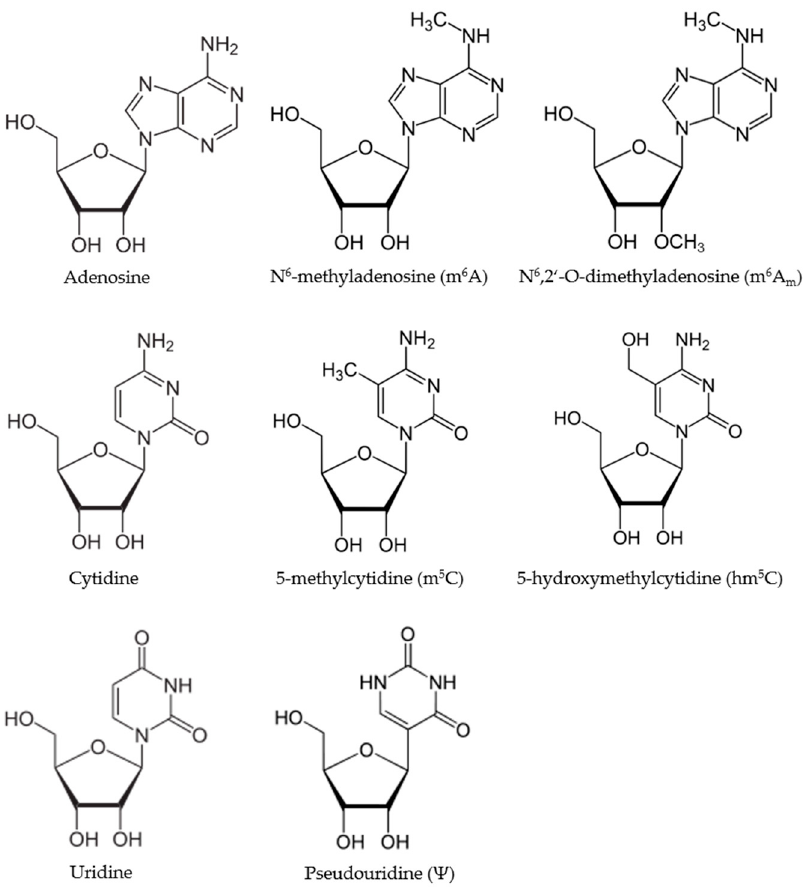
Figure 1. Selected chemical modifications present in RNA.